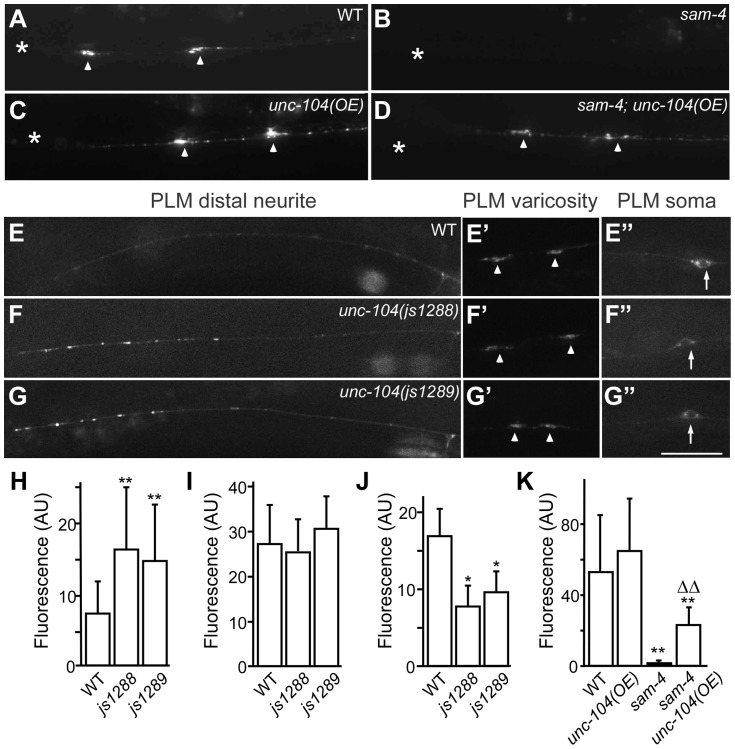

js1288 and js1289 are gain-of-function mutations in the motor domain of the unc-104 gene.(A–D) Effects of unc-104 overexpression (OE, jsIs1111) on TagRFP-RAB-3 (jsIs1263) accumulation in PLM synaptic varicosities of wild type (A and C) and sam-4 (js415) (B and D). (E–G″) Distribution of the SV marker GFP-RAB-3 in PLM neurons. Shown are representative images of the GFP-RAB-3 (jsIs821) signal observed in the distal end of PLM neurites (E–G), the PLM synaptic varicosities (E′–G′), and the PLM soma (E″–G″). Arrow: PLM soma; arrowhead: PLM synaptic varicosity; asterisk: vulva. Scale bar: 20 µm. (H–J) Quantification of GFP- RAB-3 fluorescence intensities in the distal end of the neurite (30 µm) (H), the synaptic varicosities (I), and the soma (J). Note that, due to differences between imaging conditions for individual PLM anatomic regions, arbitrary units and fluorescence intensity between regions are not comparable. (K) Quantification of TagRFP-RAB-3 fluorescence intensity in PLM synaptic varicosities in different genetic backgrounds. *, P<0.01 relative to wild type; **, P<0.001 relative to wild type; ΔΔ, P<0.001 relative to sam-4(js415).